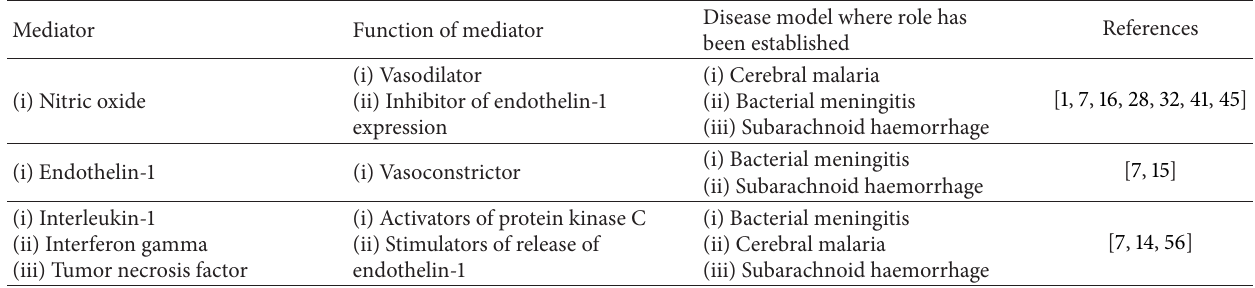
Table 1: Inflammatory mediators and their role in cerebral